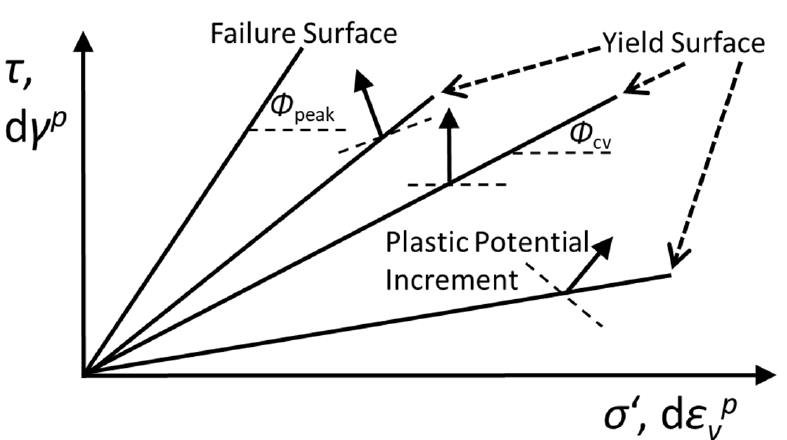
Figure 1. Yield surface, flow rule, and directions of plastic potential increments of the UBCSAND model.